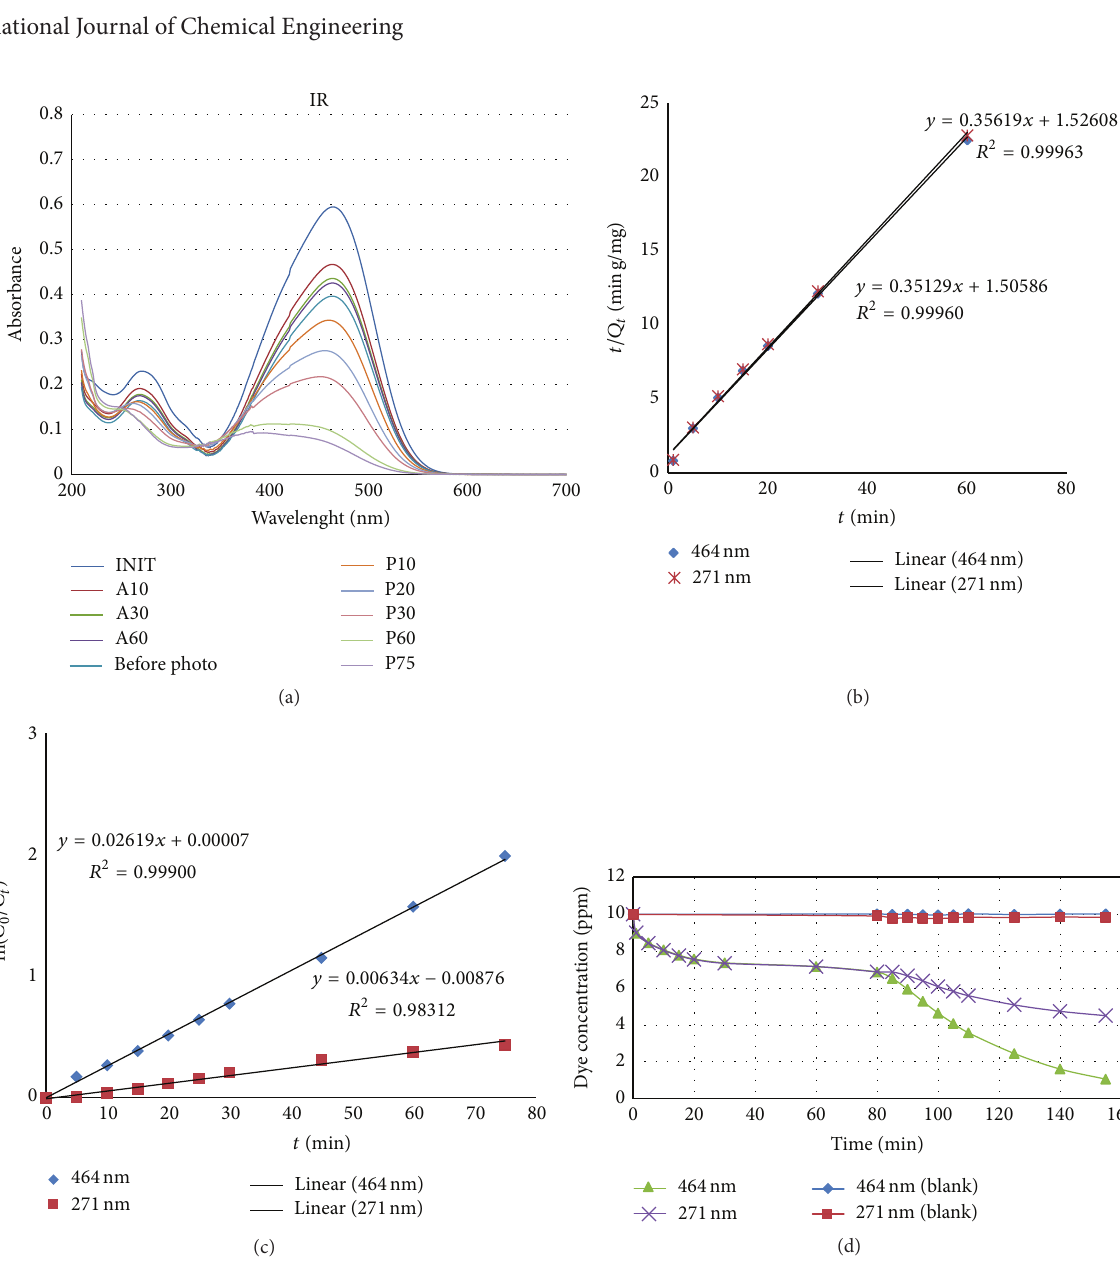
Figure 8: (a) UV-visible absorbance spectra of samples during experiment. (b) The corresponding linearized plots of pseudo-second order adsorption kinetics. (c) The corresponding linearized plots of pseudo-first order photodegradation kinetics. (d) The corresponding methyl orange adsorption-photodegradation